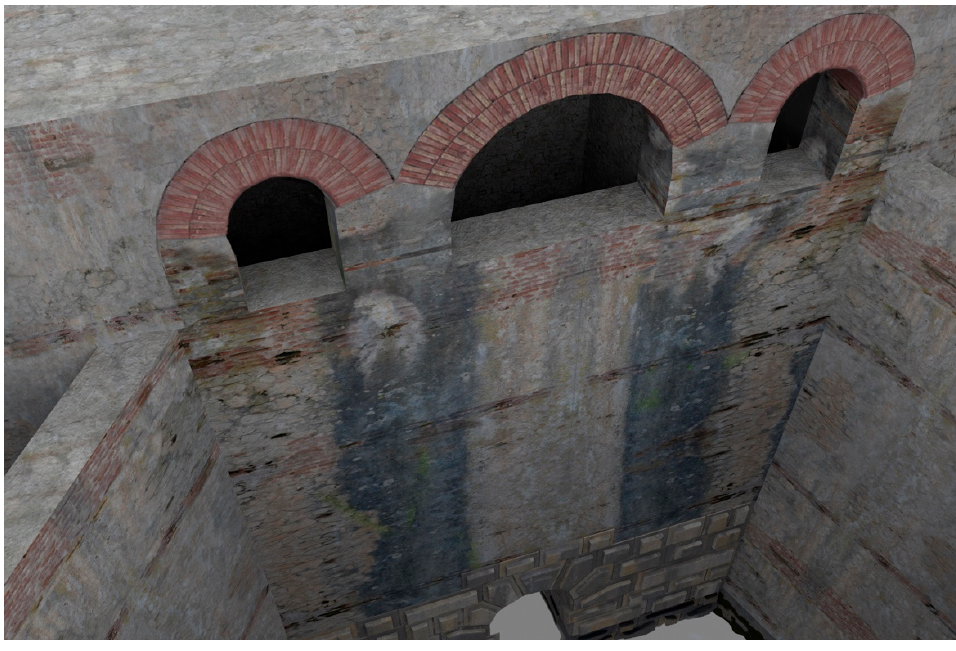
Figure 13. Detail of the virtual reconstruction of the trapezoidal tank.